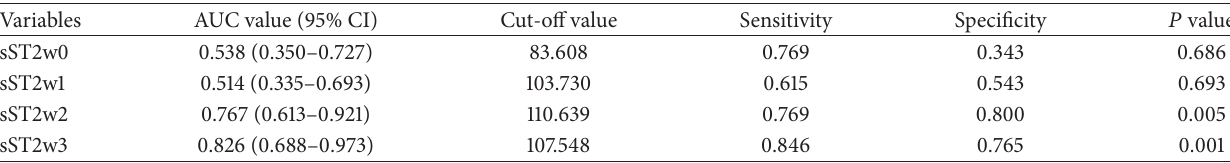
Table 4: Area under the curve (AUC), sensitivity, and specificity of the receiver operating characteristic curve to determine the ability of plasma soluble (sST2) concentration to predict survival in patients with hepatitis B virus-related acute-on-chronic liver failure.